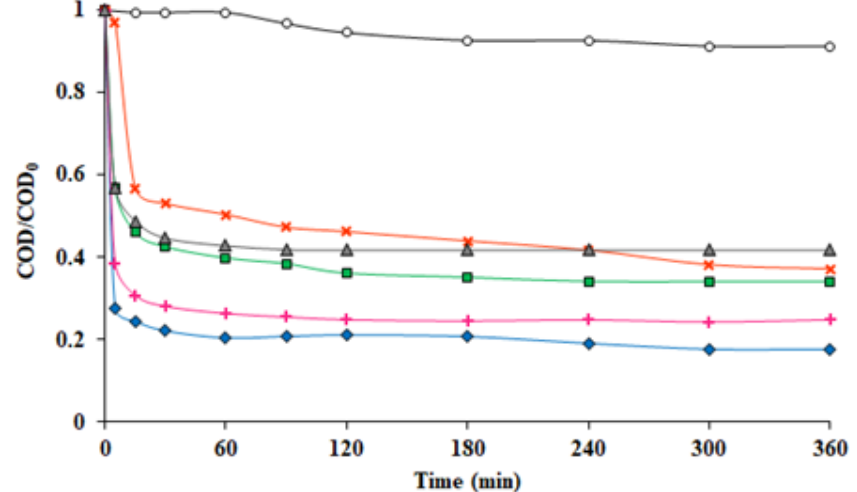
Figure 5. Evolution of chemical oxygen demand (COD) concentration with time in absence of catalyst ), and in presence of the eggshell ( (cid:78) ) and the supported catalysts: Fe 5% ( + ), Fe 15% ( × ), Cu 5% ( (cid:4) ) (  ), and in presence of the eggshell (  ) and the supported catalysts: Fe 5% (+), Fe 15% (  ), Cu 5% (  ) and Cu 15% ( (cid:7) ). In all cases, T = 150 ◦ C, P = 40 bar, pH = 7.5, initial COD concentration = 367 ppm and and Cu 15% (  ). In all cases, T = 150  C, P = 40 bar, pH = 7.5, initial COD concentration = 367 ppm and catalyst concentration = 1 g / catalyst concentration = 1 g/L.